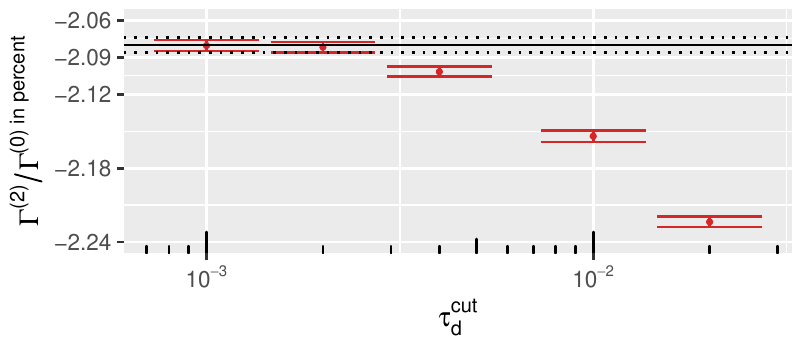
Figure 4 . τ cut -dependence of the top-quark decay width NNLO corrections. Error-bars indicate d numerical integration uncertainties. The solid line (with dashed band) indicates the fitted result (and uncertainties), which agrees with the result using τ cut